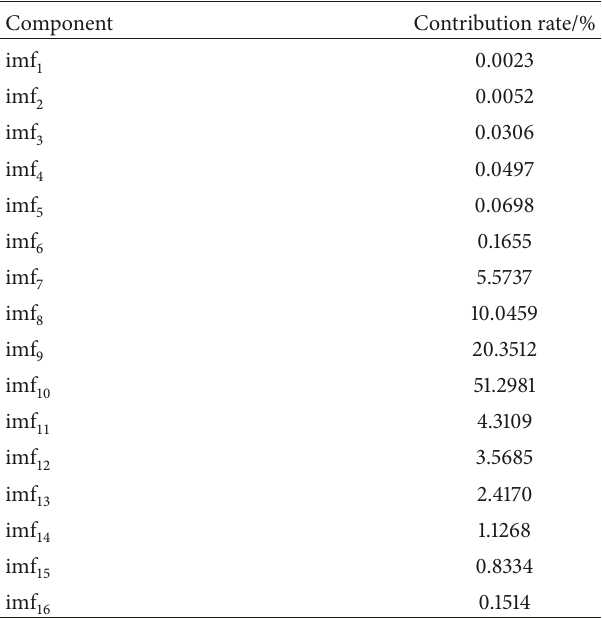
Table 3: IMF components’ variance contribution rates of vibration velocity signal at outer surface.